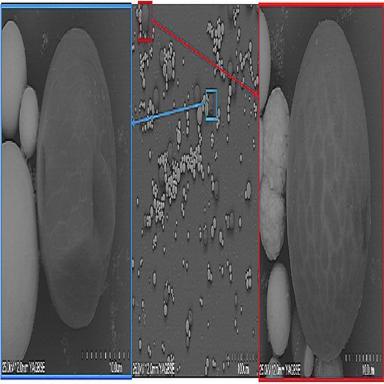
Image showing mainly the morphologies of black particles being attributed to Al/AlC particles.